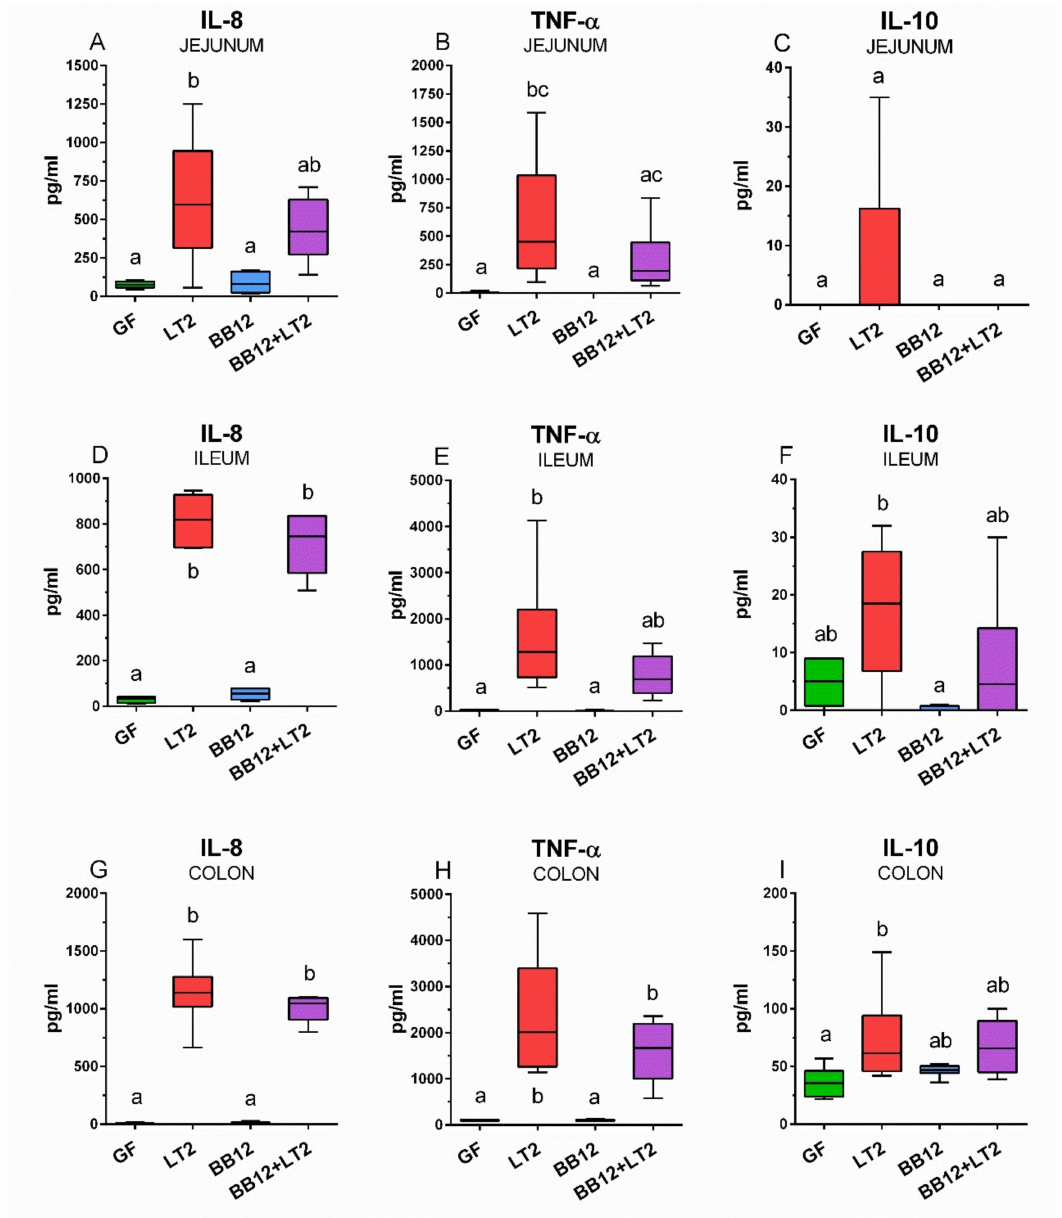
Figure 6. Intestinal levels of the inflammatory cytokines IL-8 ( A , D , G ), TNF- α ( B , E , H ) and IL-10 ( C , F , I ) in the jejunum ( A – C ), ileum ( D – F ), and colon ( G – I ) of the gnotobiotic piglets: germ-free (GF), infected with S . Typhimurium LT2 for 24 h (LT2), associated with B. animalis subsp. lactis BB-12 (BB12), and associated with BB12 and infected with LT2 for 24 h (BB12 + LT2). The values are presented as boxes indicating the lower and upper quartiles, the central line is the median, and the ends of the whiskers depict the minimal and maximal values. Statistical differences were calculated by the Kruskal–Wallis test with Dunn’s multiple comparison post hoc test, and p < 0.05 are denoted with different letters above the columns. Six samples in each group were